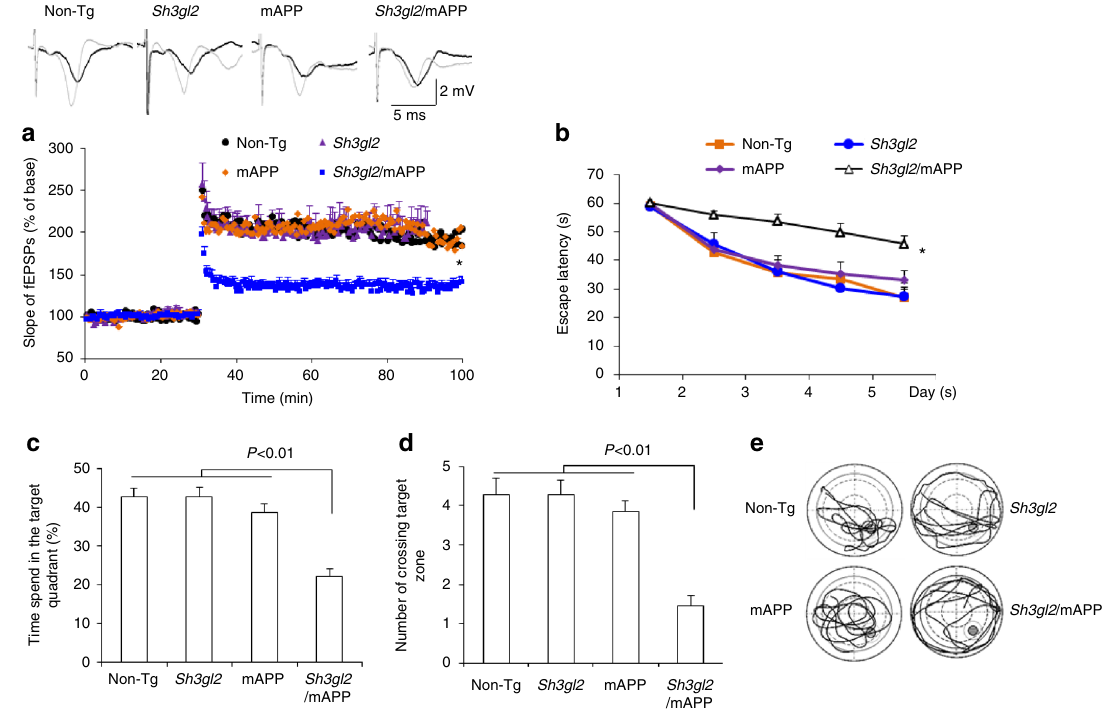
Fig. 2 Effect of EP overexpression on synaptic plasticity and spatial learning and memory in transgenic Tg Sh3gl2 / mAPP mice. a Tg Sh3gl2 or mAPP at 5 – 6 months of age do not alter hippocampal LTP, but the hippocampal LTP is signi fi cantly reduced in Tg Sh3gl2 /mAPP mice as compared with non-Tg mice. Error bars represent s.e.m., n = 7 – 10 per group; * p < 0.01 (one-way ANOVA). Upper panel shows representative traces of fEPSP in the indicated slices before θ -burst stimulation (black line) and after 1 h (gray line). b – e Mice were tested in Morris water maze at the age of 5 – 5.5 months. b Escape latencies in hidden platform during Morris water maze task training in indicated groups of mice. Error bars represent s.e.m., n = 8 – 9 mice per group (one- way ANOVA in b ). c Time spent in the quadrant with the hidden platform and d mean number of crossings of the target during the probe test. e The representative searching traces during the probe test. Data are shown as mean ± s.e.m., n = 8 – 9 mice per group (one-way ANOVA in c , d )